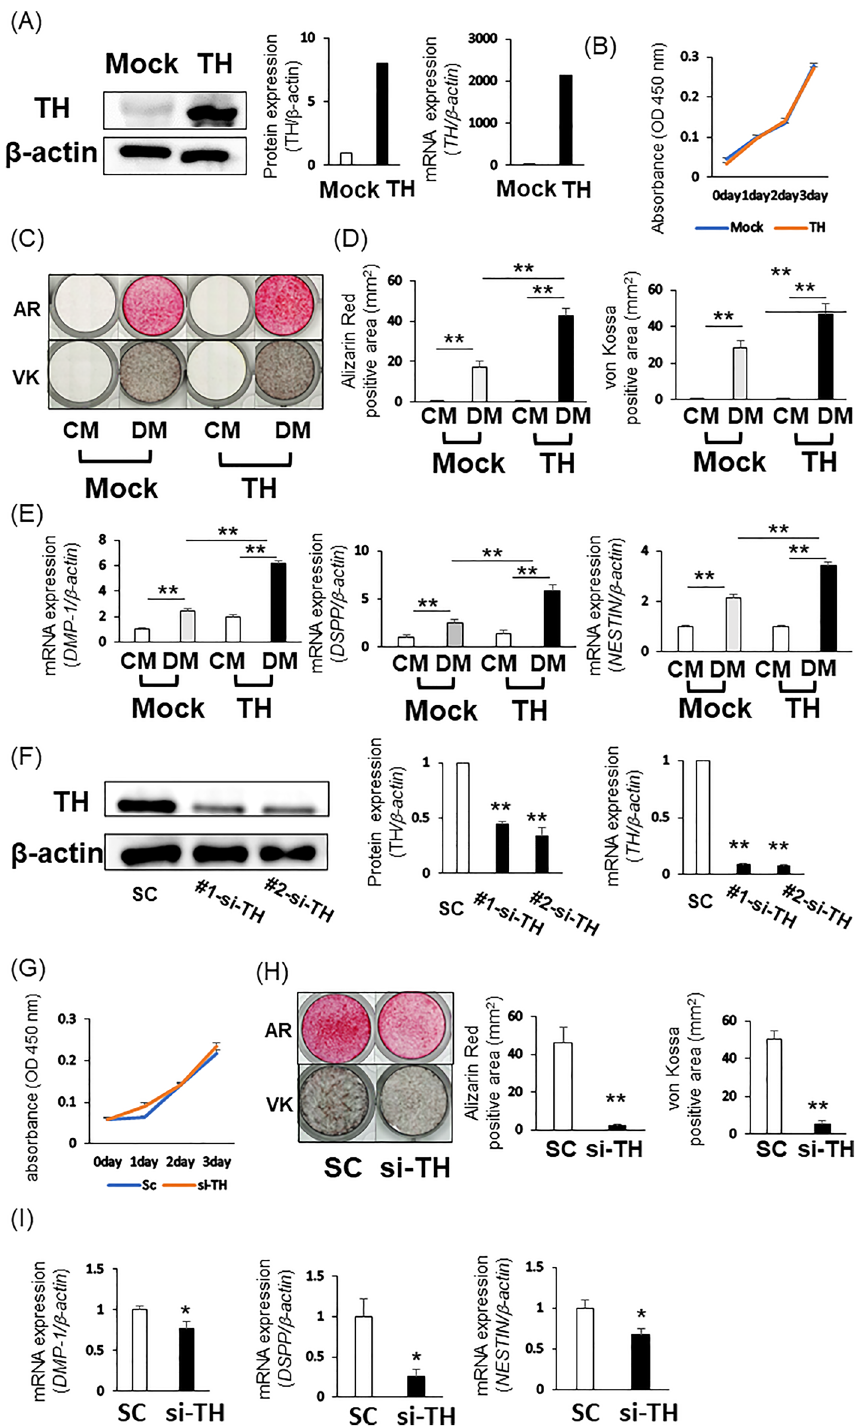
Figure 3. Effects of TH overexpression on the odontoblastic differentiation of DPSCs-3U. (A-E) Mock- and TH-DPSCs were cultured in CM or DM. ( A ) Gene and protein expression of TH were investigated by quantitative RT-PCR and Western blotting. The bands were quantified using ImageJ ( B ) Proliferation of Mock-DPSCs or TH-DPSCs was examined by WST-1 assay. ( C ) Alizarin Red S staining and von Kossa staining of Mock-DPSCs or TH-DPSCs cultured in CM or DM. ( D ) Positive area of Alizarin Red S staining and von Kossa staining was quantified using a Keyence BZ-9000 microscope with BZ-H4M/BZ-H4C/BZ-H4CM software. ( E ) Gene expression of DMP-1, DSPP, and NESTIN was investigated by quantitative RT-PCR. ( F – I ) TH-DPSCs was transfected with control siRNA or TH siRNA. ( F ) Gene and protein expression of TH were confirmed by quantitative RT-PCR and Western blotting. The bands were quantified using ImageJ. ( G ) Proliferation of TH-DPSCs transfected with control siRNA or TH siRNA was examined by WST-1 assay. ( H ) Alizarin Red S staining and von Kossa staining of TH-DPSCs transfected with control siRNA or TH siRNA cultured in DM. The positive areas were quantified by Keyence BZ-9000 microscope with BZ-H4M/BZ-H4C/BZ-H4CM software. ( I ) Gene expression of DMP-1, DSPP, and NESTIN was examined by quantitative RT-PCR. β-actin was used an internal control. Statistical analysis was performed using the Student’s unpaired t-test or one-way ANOVA followed by Bonferroni’s test with Easy R software. n = 3, ** P < 0.01, * P < 0.05. Original blots are presented in Supplementary Information